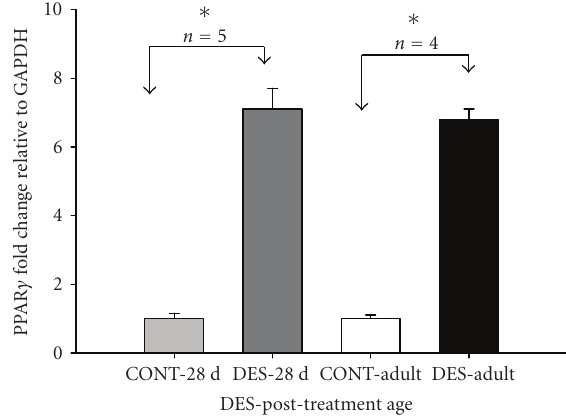
Figure 3: Real-time PCR showing 7.1 and 6.8 fold increase in PPAR γ mRNA in penile tissue of 28-day-old (DES-28 d) and adult rats (DES-Adult) neonatally treated with DES, respectively. Fold change was calculated relative to respective controls (CONT-28 d and CONT-Adult). Data ( n = 4-5) are expressed as mean ± SE. ∗ P < .